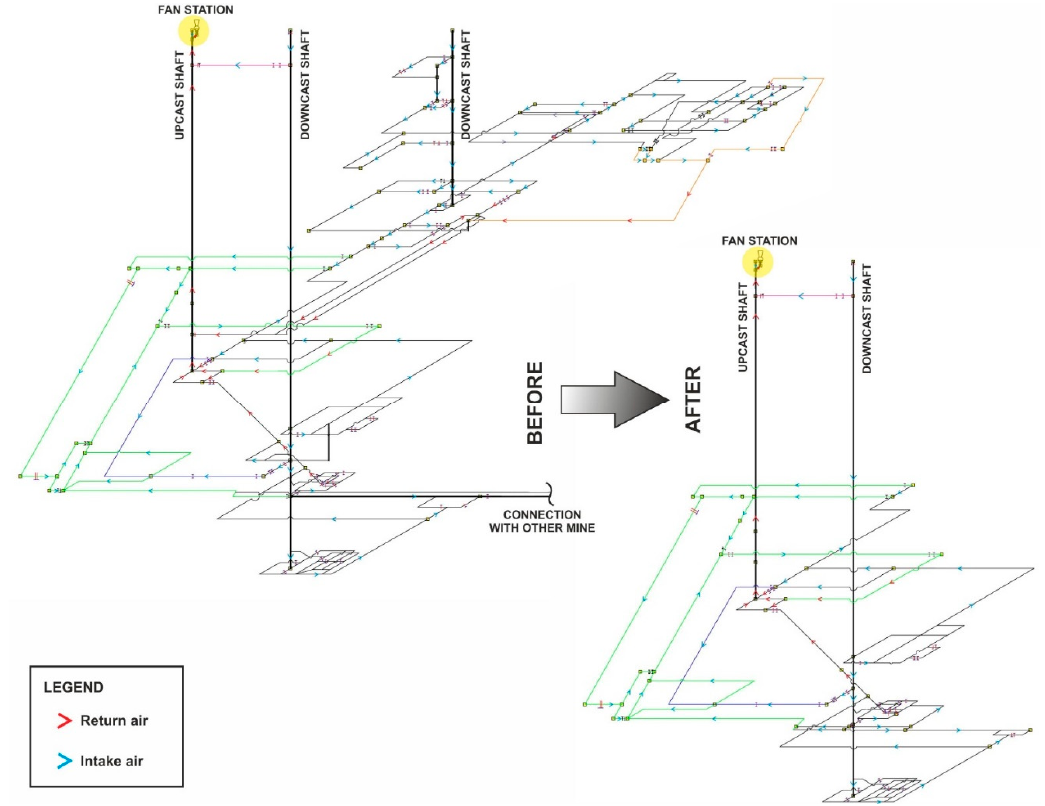
Figure 1. Mine scheme before and after the decommissioning.